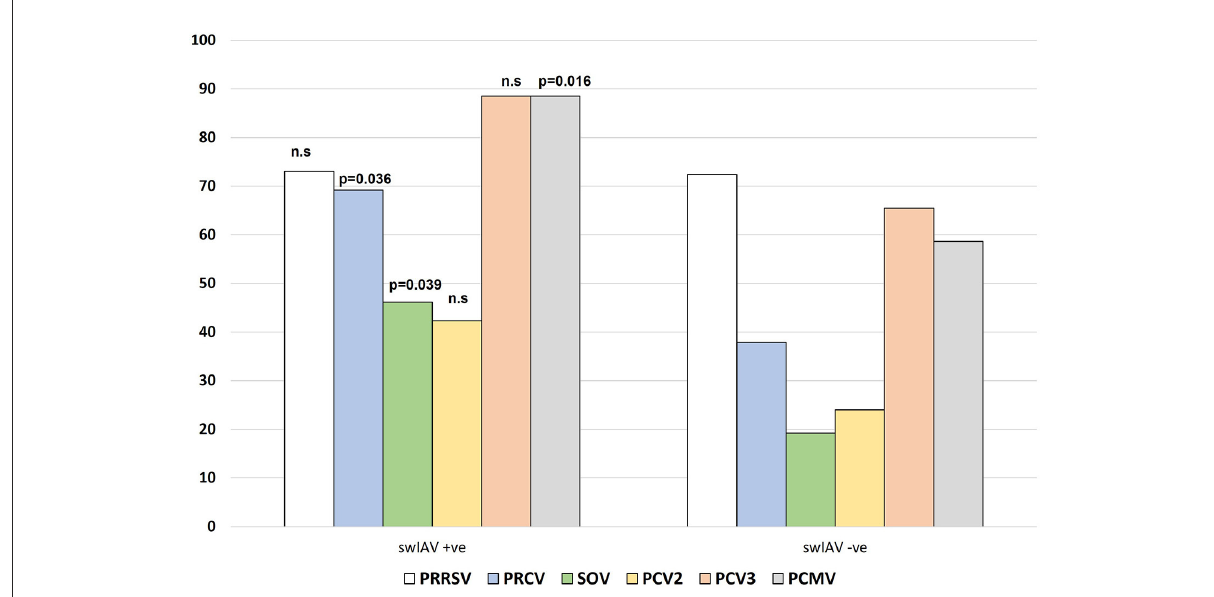
FIGURE1 Frequency of detection of the different viruses in the studied cases, based on the swIAV status of the nursery. n.s, not